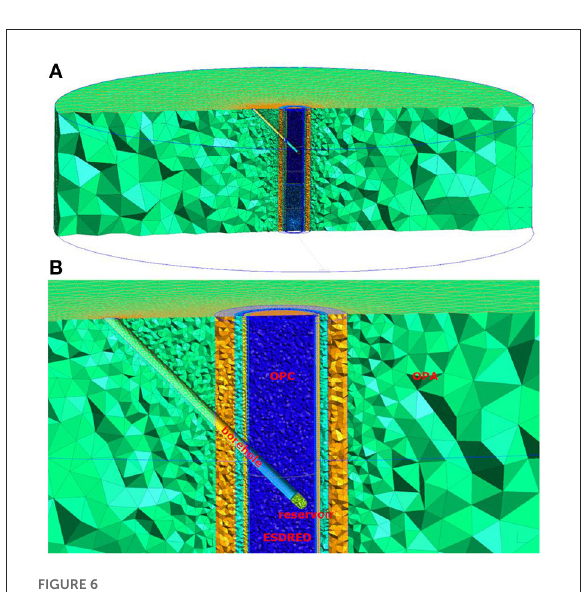
FIGURE6 Illustration of simulation domain for in-situ experiment using tetrahedral cells, (A) the entire simulation domain, and (B) borehole